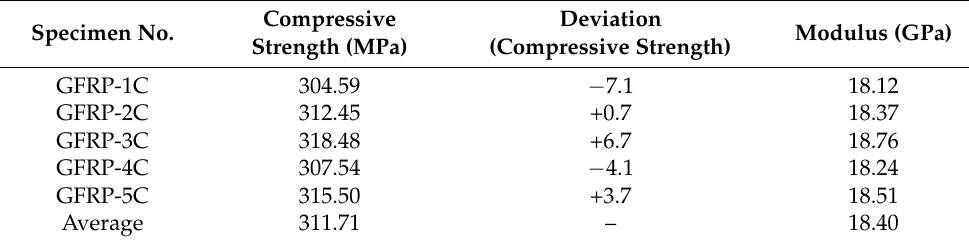
Table 2. Mechanical properties of compression specimen.